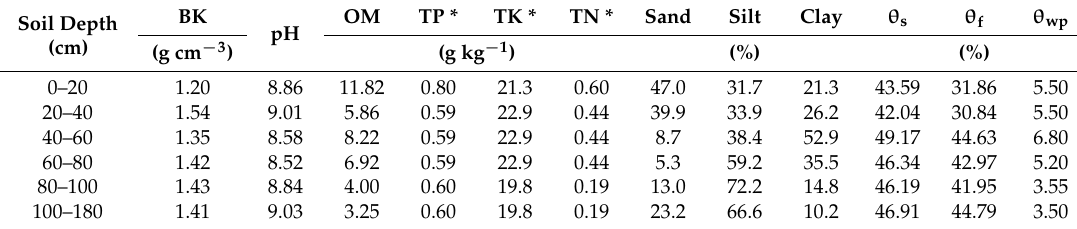
Figure 1. Schematic locations of the Fengqiu Agro-ecological Experimental Station and the Huang-Huai-Hai Plain in China [37]. Table 1. Soil physical and chemical properties.